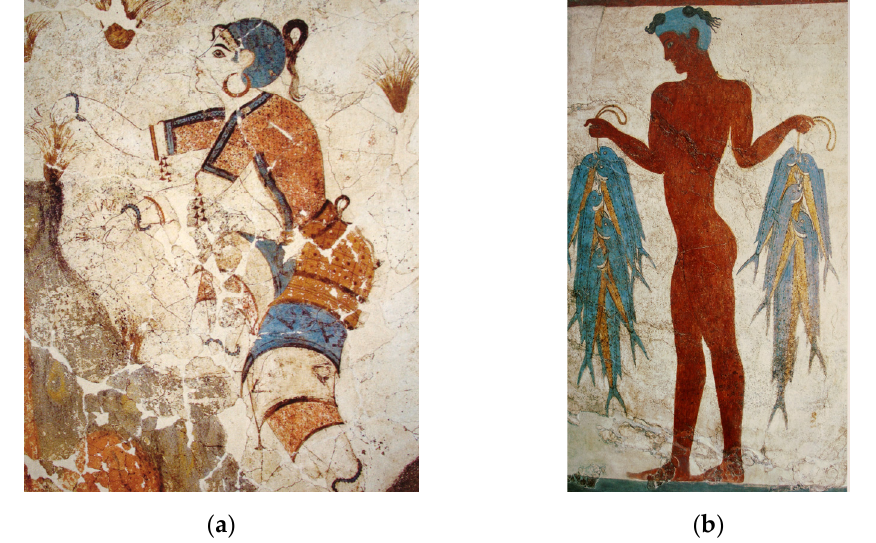
Figure 17. Akrotiri, Santorini c. 1600–1500 BC ( a ) Saffron gatherers [199] and ( b ) fishermen [200].